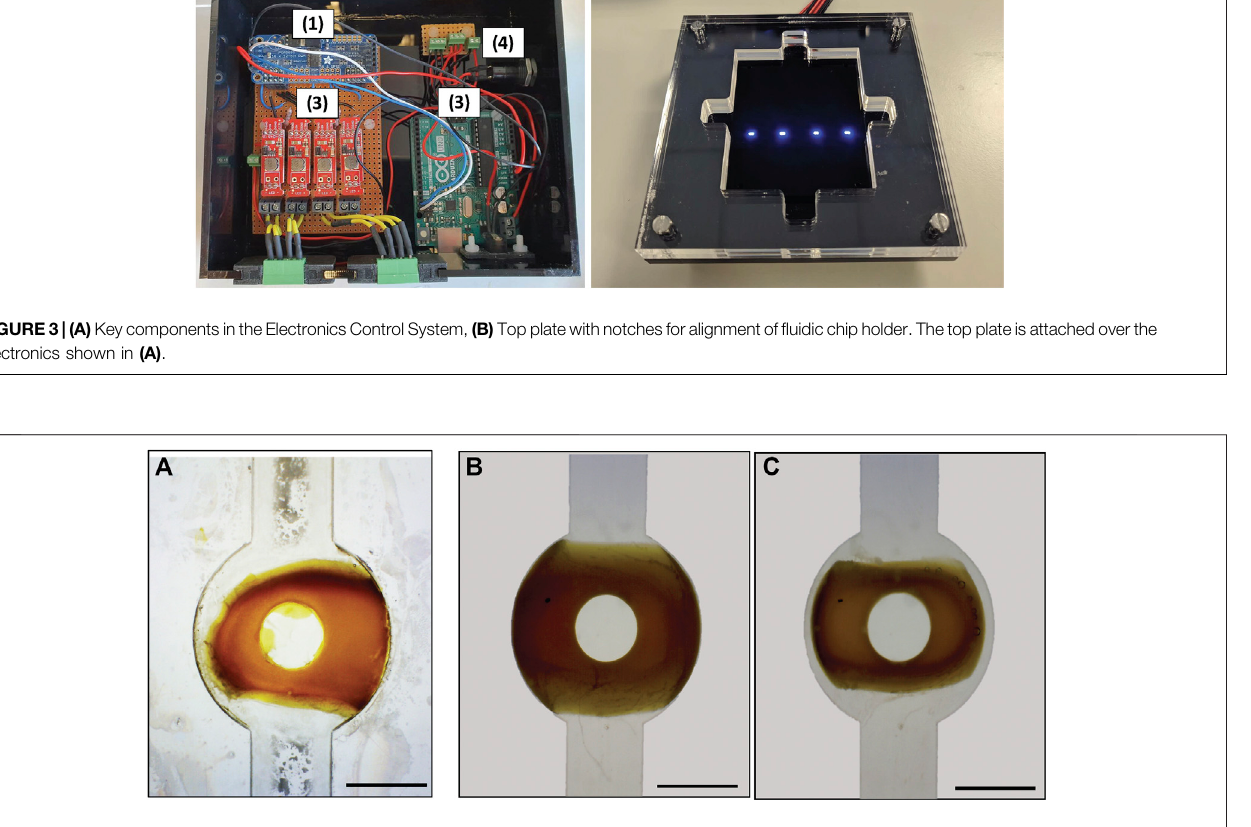
FIGURE 4 | (A) Microscope Image of the soft polymer valve within the fl uidic chip before LED hot-spot correction and (B) after correction. (A) Valve produced without accurate LED alignment around the retention pillar is misshapen and cannot fully close; (B) Accurate alignment of the LED coupled with 3-layer diffuser has a much more regular shape nicely centered around the retention pillar within the valve housing feature; (C) Exposure to UV-light triggers contraction of the valve allowing fl ow to occur. The size bar is 1,200 μ